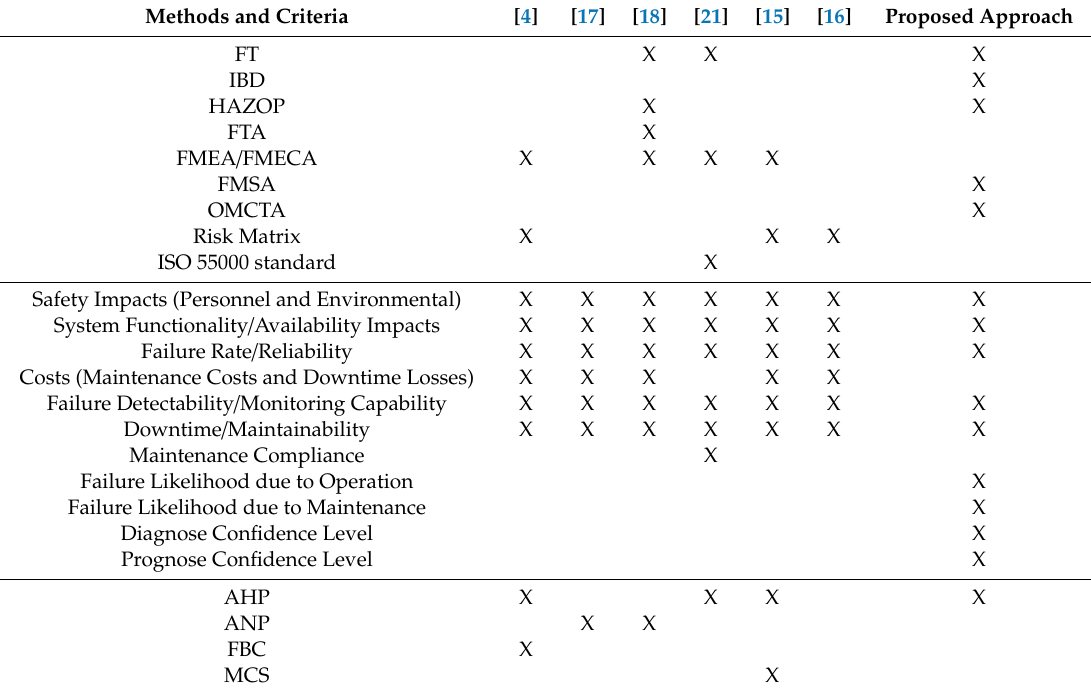
Table 1. Comparison of the Methods and